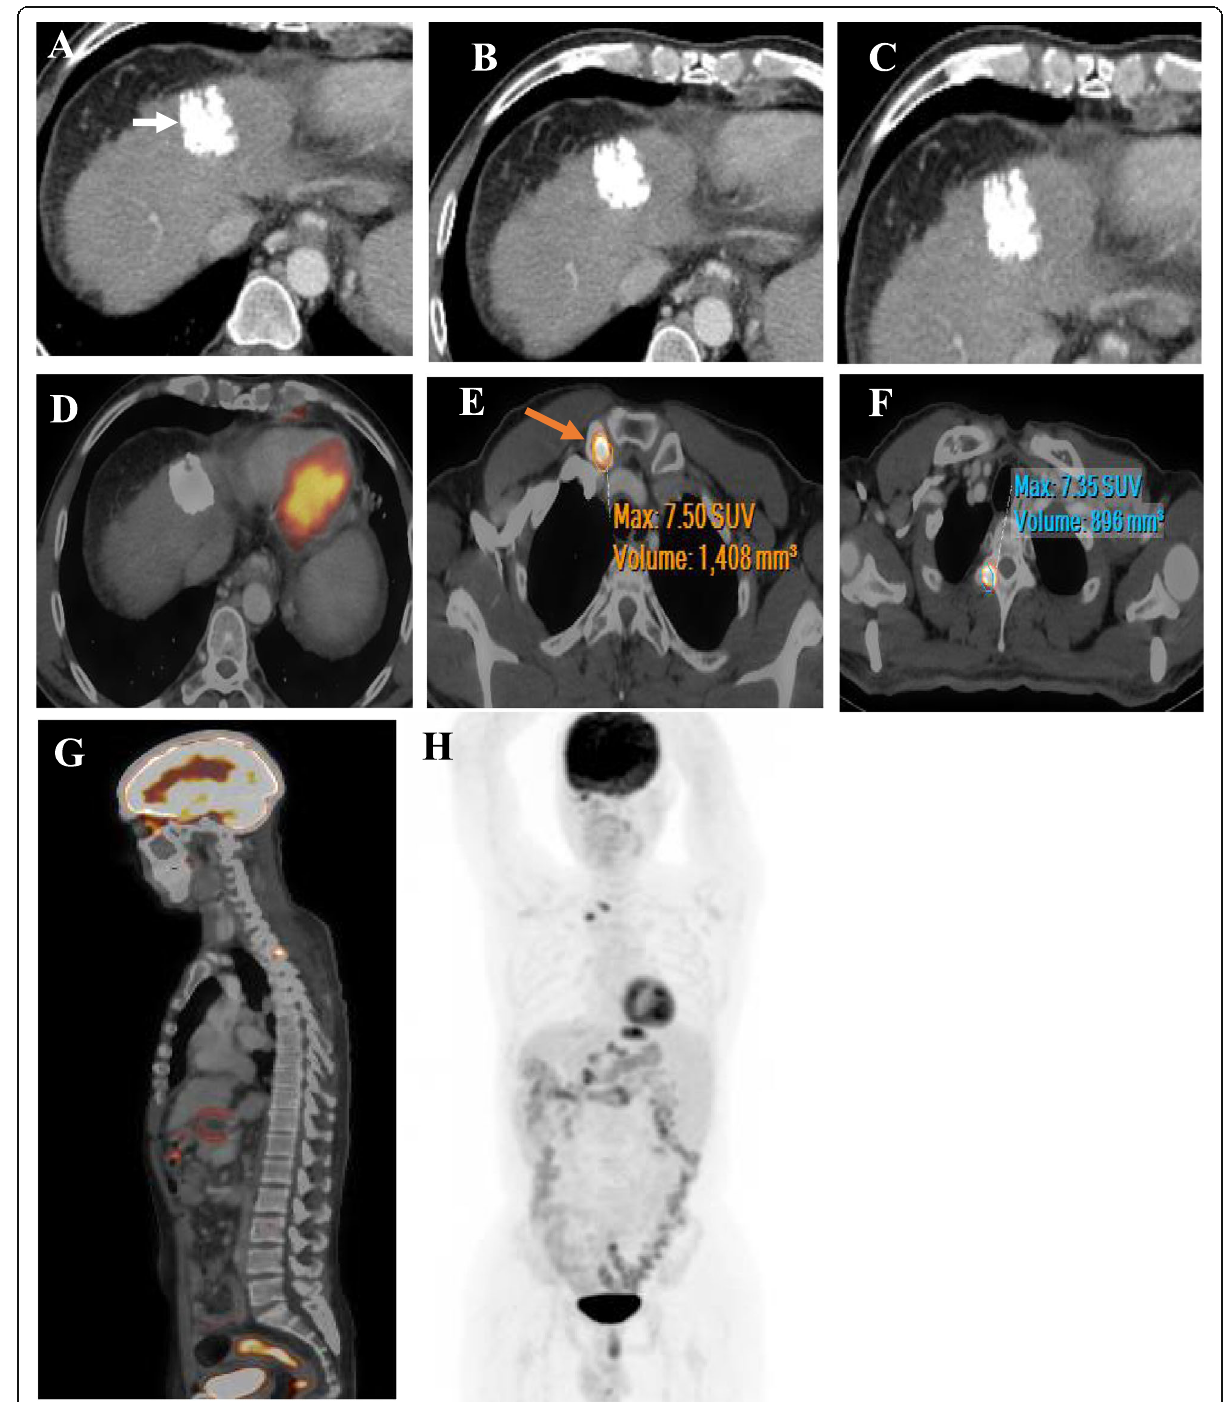
Fig. 6 a – c CECT phases showing lipiodol concentration at chemoembolized lesion at the left lobe (arrow). d Fused PET/CT images showing well ablation of the embolized lesion with no activity detected. e Axial fused PET/CT shows hypermetabolic metastatic bony lesion at the right clavicle(red arrow). f Axial fused PET/CT shows hypermetabolic metastatic bony lesion at D2 vertebra. g Sagittal fused PET/CT whole spine shows D2 osseous deposit. h 3D CTAC summarizing the whole